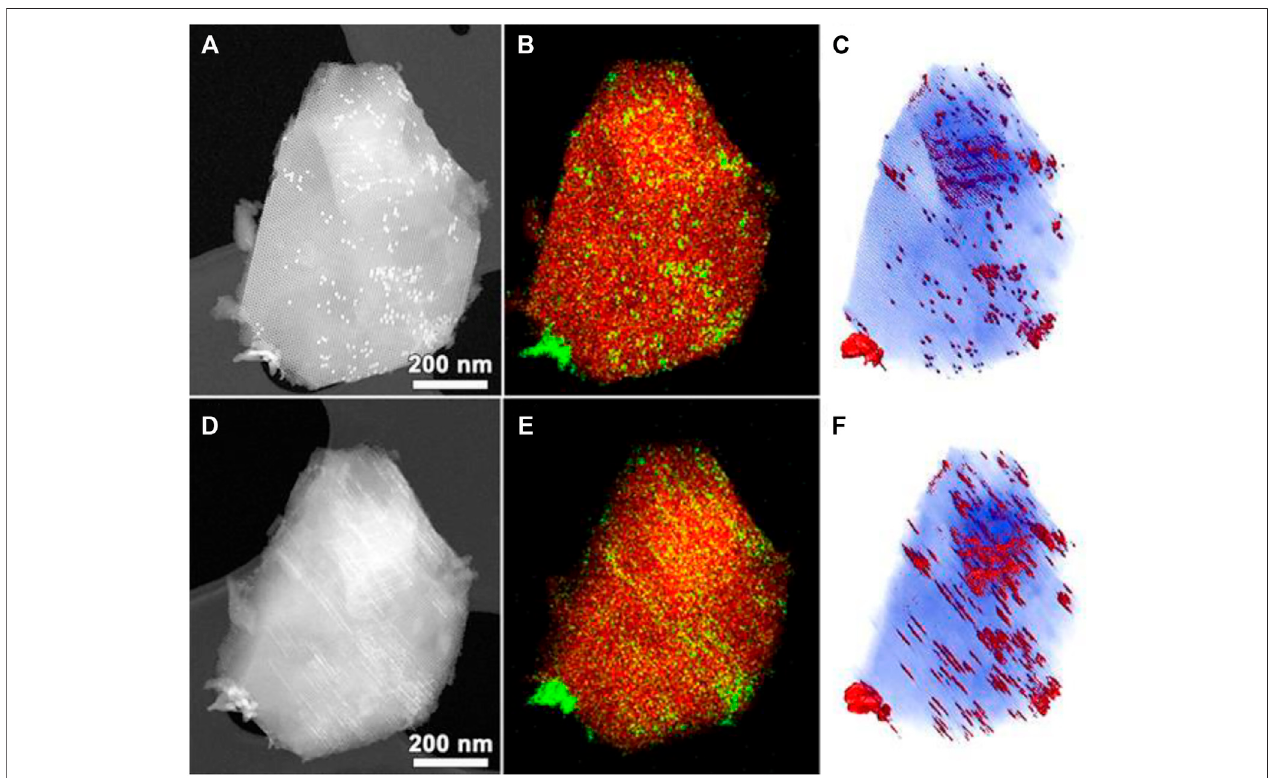
FIGURE16| Electronmicroscopicinvestigationof α -Fe 2 O 3 @COK-12. (A – C) HAADF-STEMimageof α -Fe2O3@COK-12,EDXelementalmapping(green — Feand red — Si),HAADF-STEMtomographyreconstruction,respectively,alongtheporedirectionand (D – F) similarobservationsalongthedirectionslightlyperpendiculartothe pore (reproduced from Wee et al., 2015 with permission from the Royal Society of